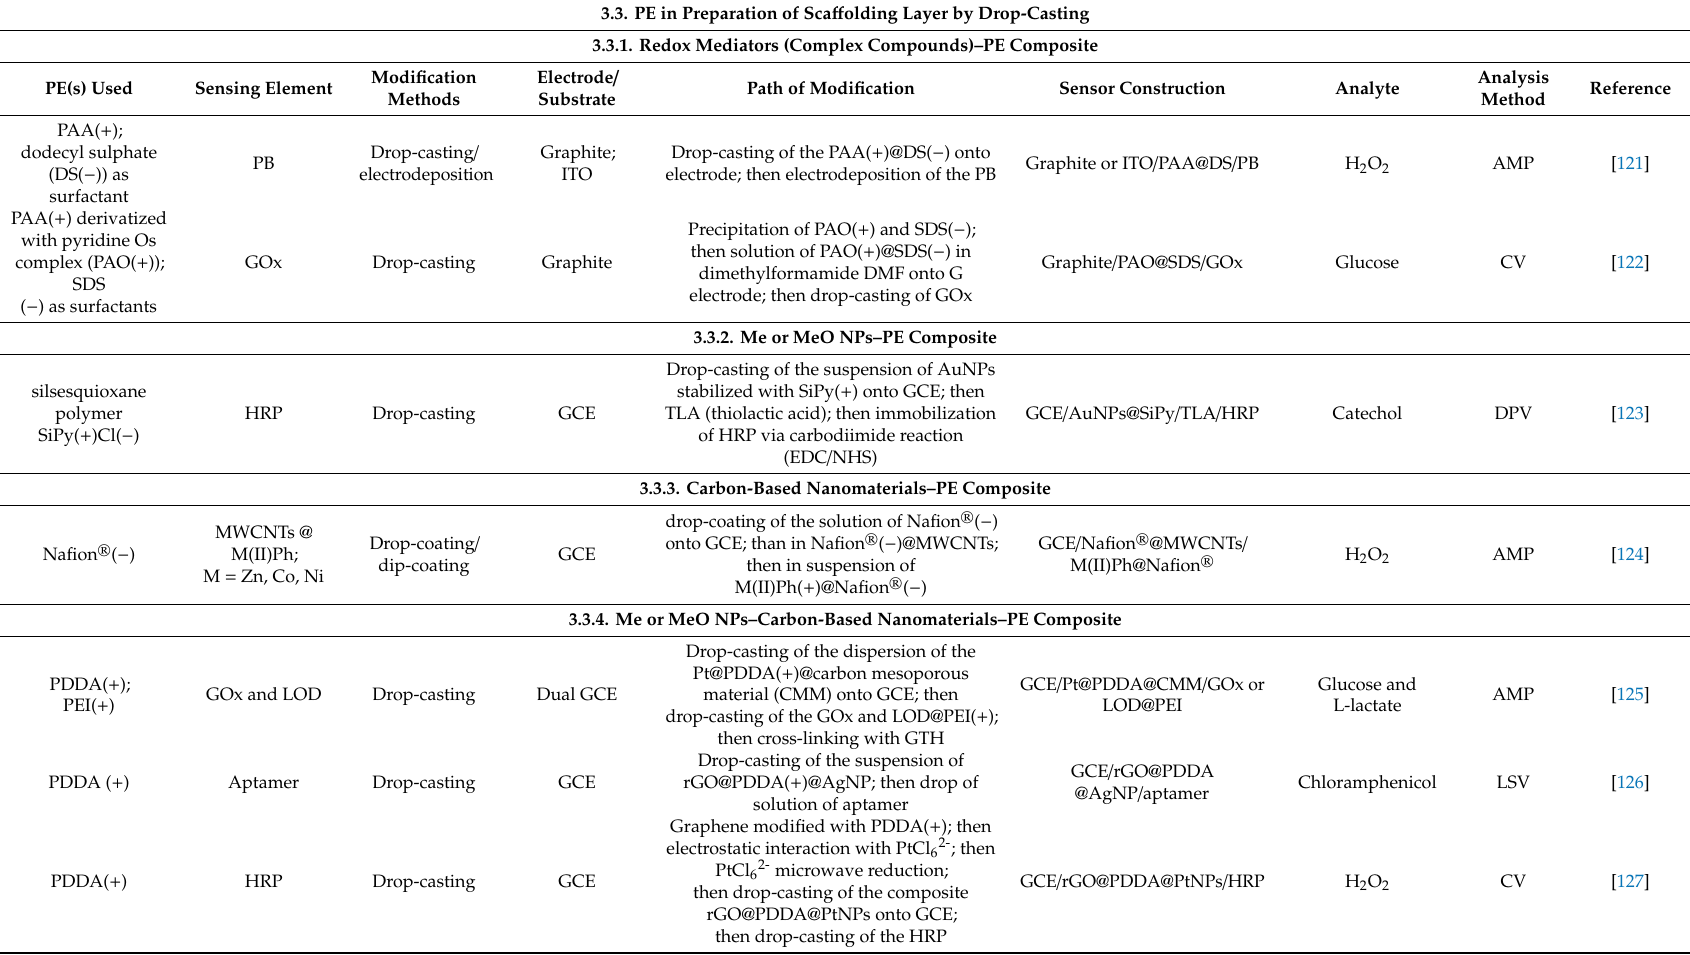
Table 7. Summary of electrochemical sensors based on the sca ff olding polyelectrolyte-based layer, obtained by drop-casting or dip-coating